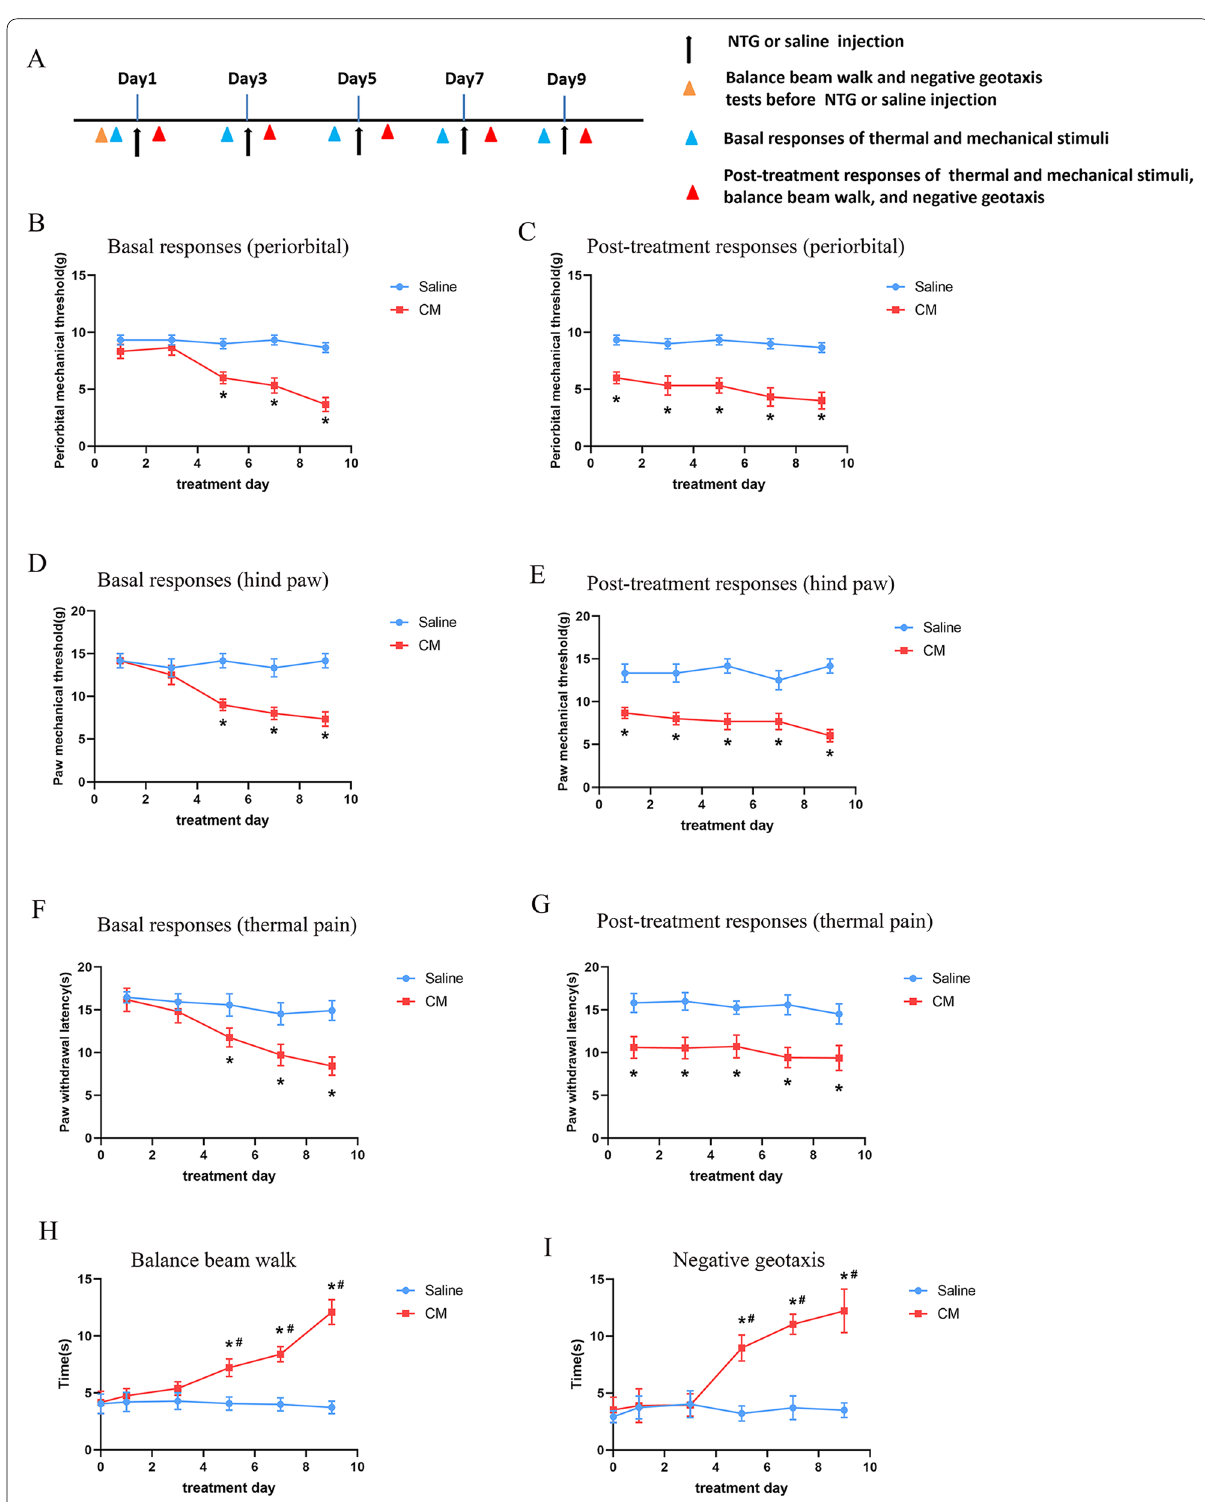
Fig. 1 Recurrent NTG administration induced mechanical allodynia, thermal hyperalgesia, and vestibular dysfunction. A. Timeline of behavior studies’ protocol. B‑G . Basal and post-treatment responses of periorbital ( B, C ) and hind paw ( D, E ) mechanical and thermal thresholds ( F, G ) after NTG injection. Balance beam walk ( H ) and geotaxis reflex test ( I ) in each group. n (ANOVA), Bonferroni; * p < 0.05 compared with saline group, # p < 0.05 compared with before NTG